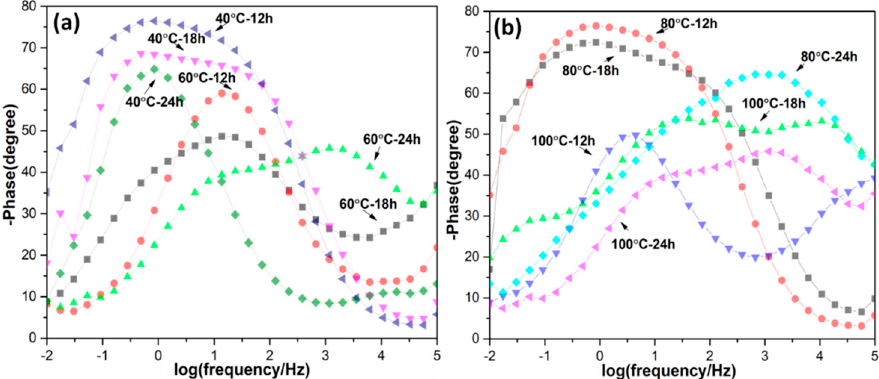
Figure 8. EIS spectra (Phase angle vs. log(frequency)) of bare AA6082 alloy and AA6082 alloy coated with LDH film at various reaction temperatures and crystallization times in 0.1 M NaCl solution.